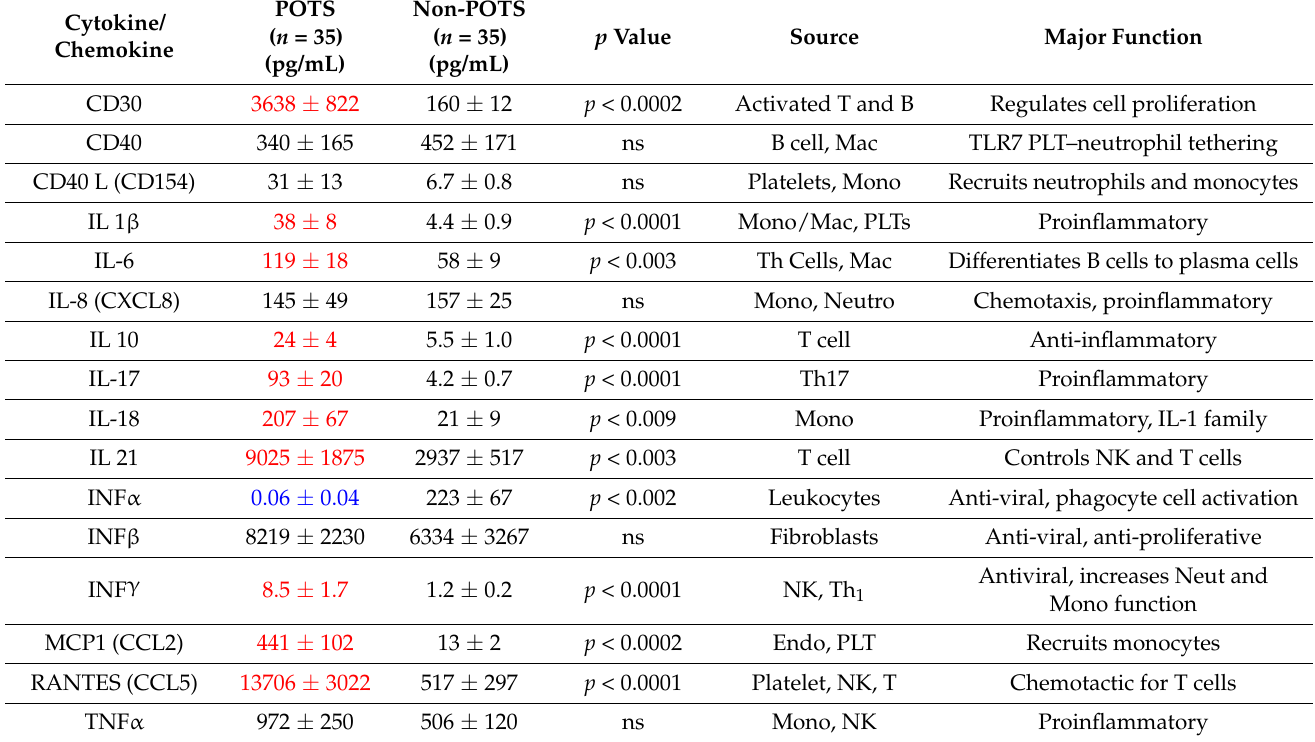
Table 1. Inflammatory biomarkers in POTS